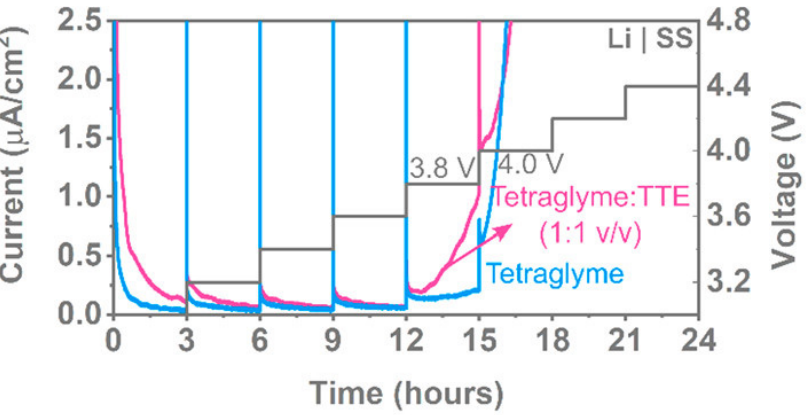
Figure 9. Potentiostatic holds for 3 h at different voltages with stainless steel as the working elec- trode and 0.1 M LiFSA in tetraglyme and tetraglyme:TTE. Reprinted with permission from ref.